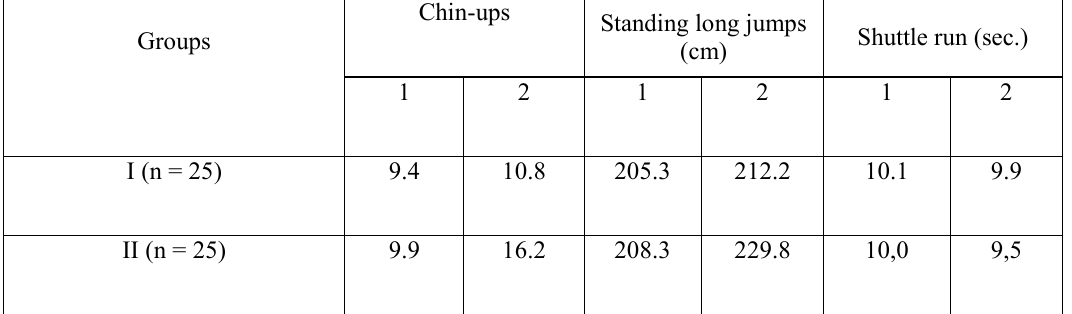
Средние значения показателей физической подготовленности студентов в начале и в конце эксперимента